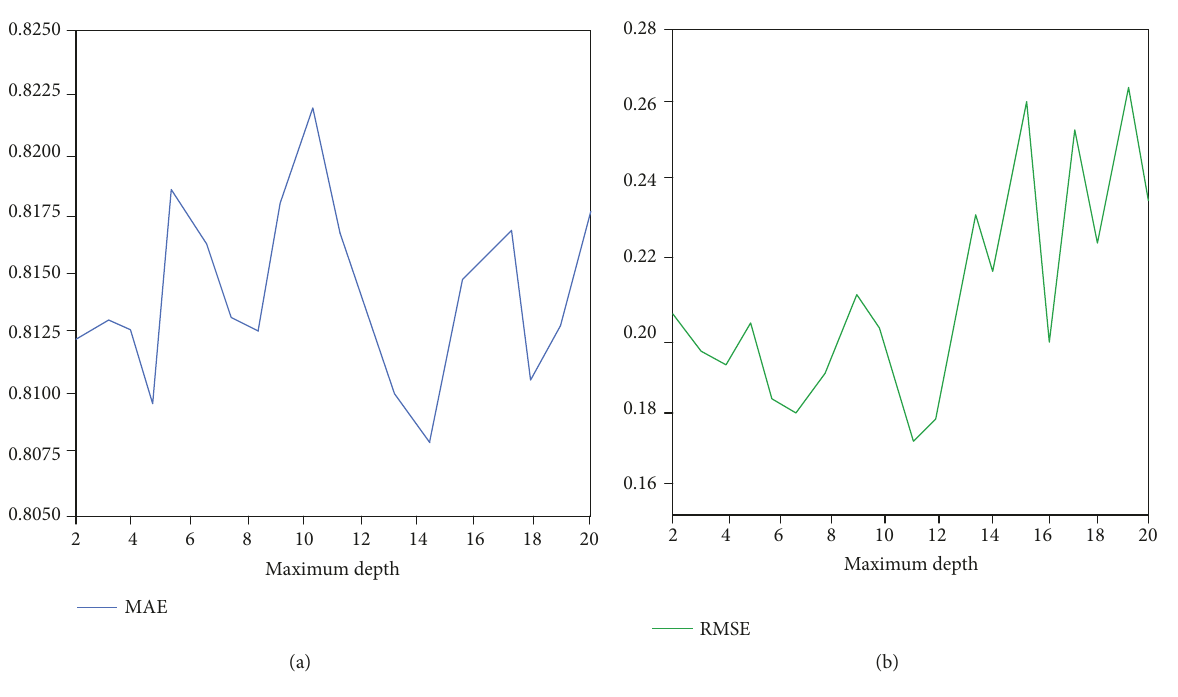
Figure 4: Statistical error results of maximum